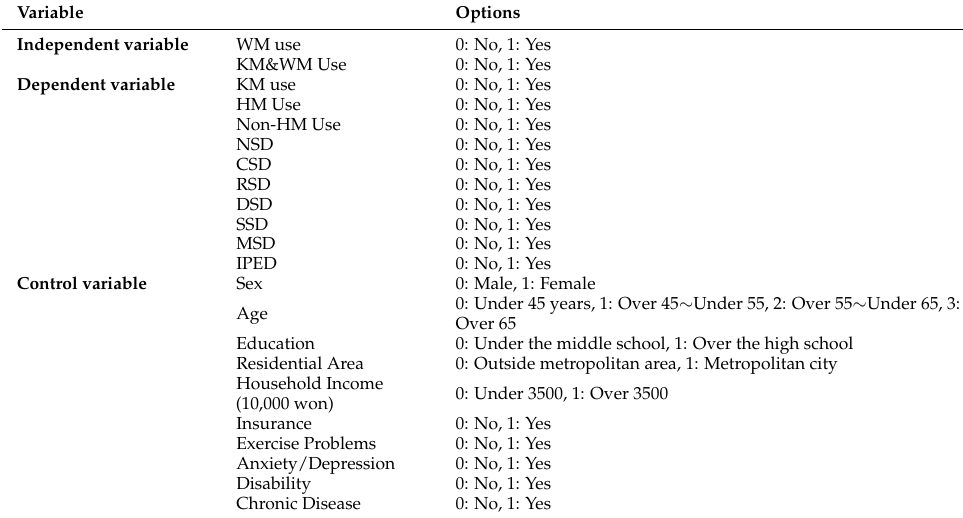
Table 1. Variables of the Factors Related to Medical Service